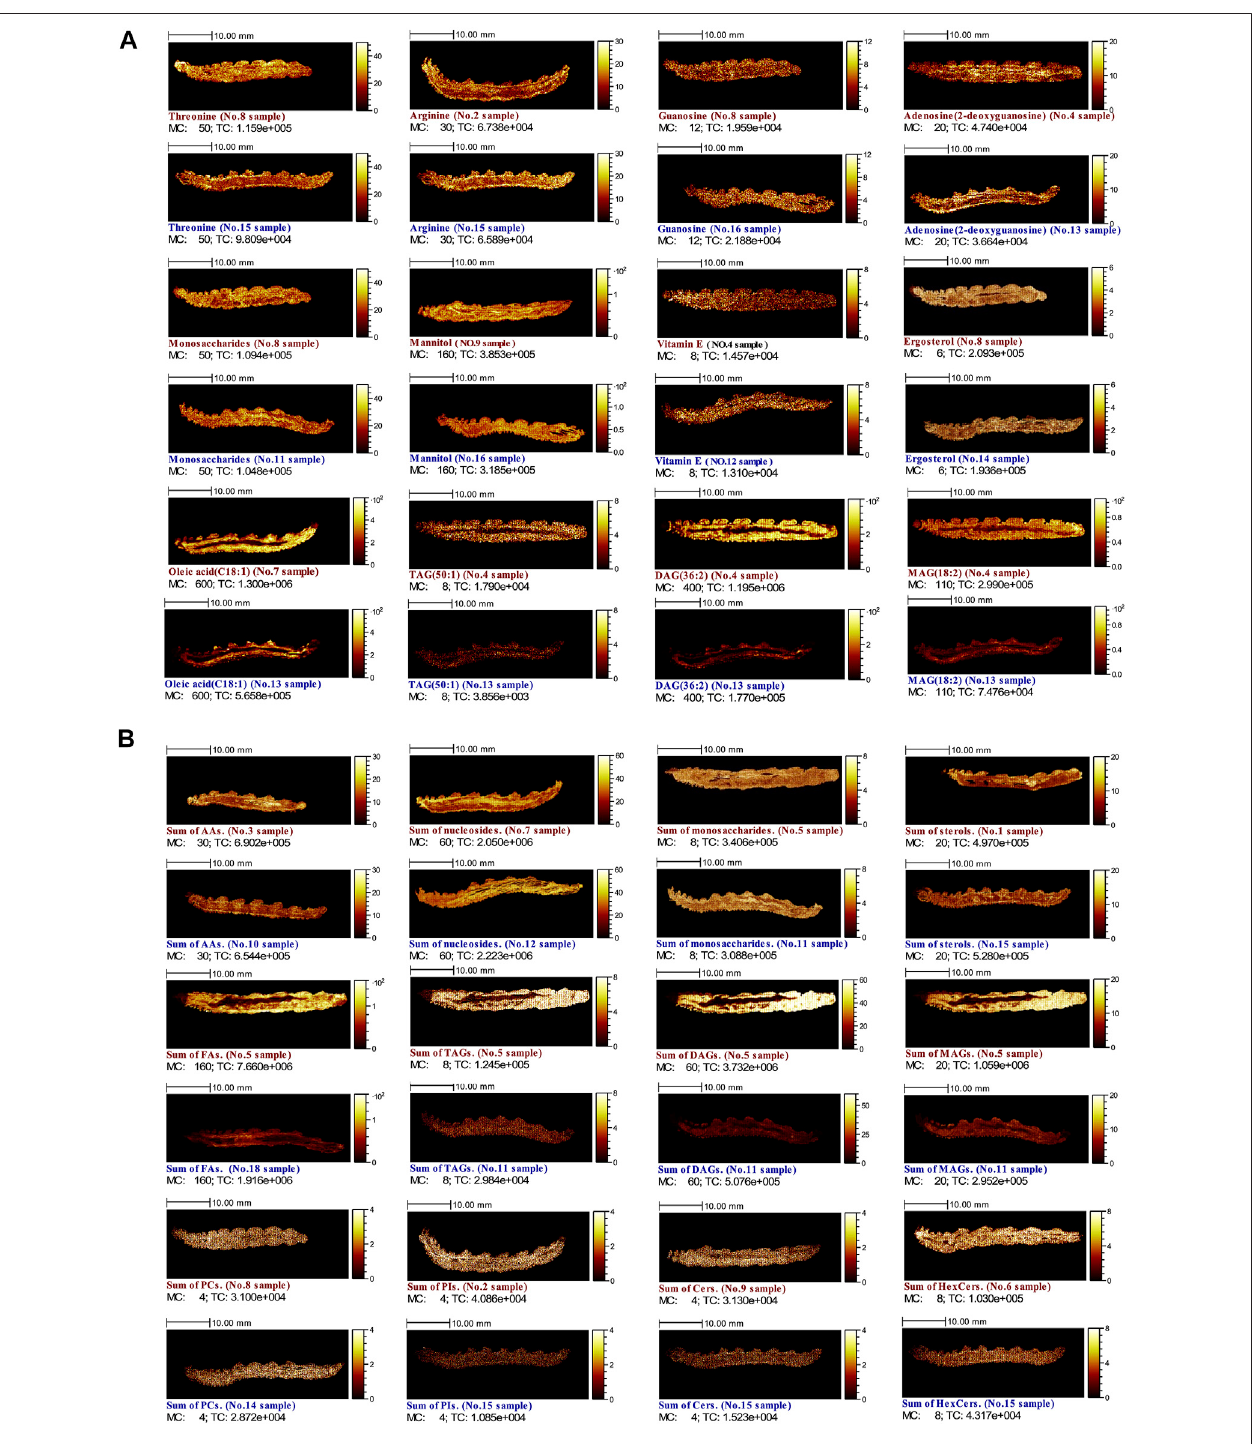
FIGURE 7 | MSIs of both CCS (No. 1 – 9 in red) and NCS (No. 10 – 18 in blue) samples (A) Selected individual components (B) Total amounts of each kind of components. The MSIs of (A) were binned with 256 pixels. Except for the sum of TAGs, PCs, PIs, Cers, and HexCers with low intensities, which were binned independently with 64 pixels, the MSIs of (B) were binned with 16 pixels. MC stands for maximum counts; TC represents total counts.